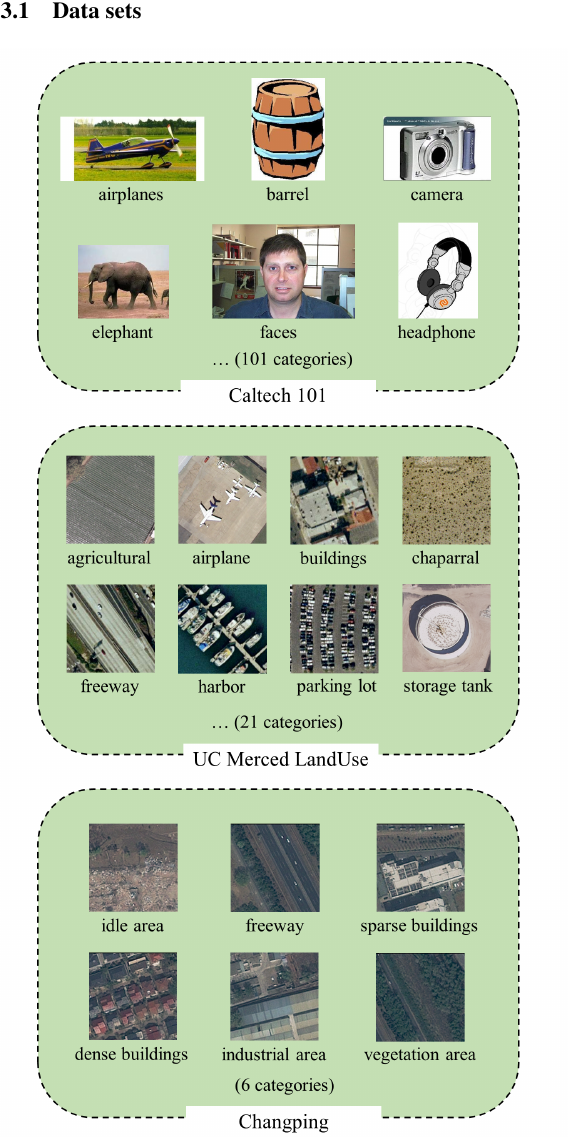
Figure 2. Sample images from three data sets